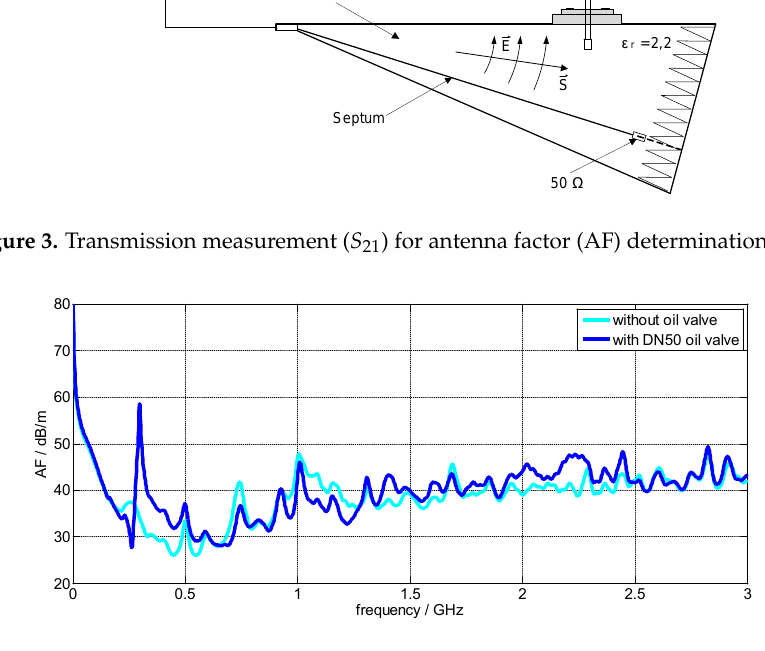
Figure 4. AF of UHF sensor measured in gigahertz-transversal-electro-magnetic (GTEM) cell [13].